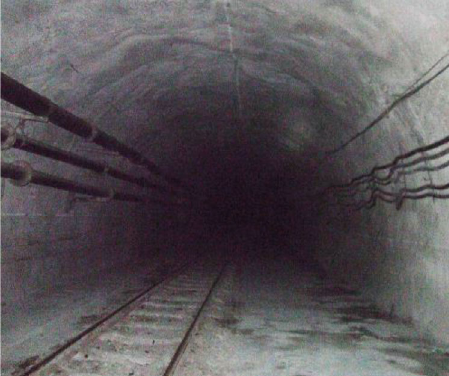
Figure 15: The supporting e ff ect